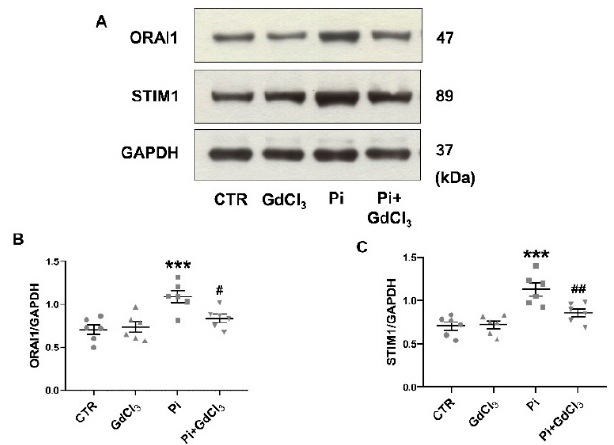
Figure 5. Reversal of ß-glycerophosphate-induced ORAI1 and STIM1 protein expression in megakaryocytes by GdCl 3 . ( A ) Original Western blots of ORAI1, STIM1 and GAPDH protein abundance in megakaryocytes without (CTR) and with prior 24-h exposure to 50 µ M GdCl 3 alone (GdCl 3 ), 2 mM ß-glycerophosphate alone (Pi) or 2 mM ß-glycerophosphate and 50 µ M GdCl 3 (Pi+GdCl 3 ). ( B , C ) Arithmetic means ± SEM ( n = 6) of ORAI1 ( B ) and STIM1 ( C ) protein abundance in megakaryocytes without (CTR) and with prior 24-h exposure to 50 µ M GdCl 3 alone (GdCl 3 ), 2 mM ß-glycerophosphate alone (Pi) or 2 mM ß-glycerophosphate and 50 µ M GdCl 3 (Pi+GdCl 3 ). *** ( p < 0.001) indicates statisti- cally significant difference compared to CTR; # ( p < 0.05), ## ( p < 0.01) indicate statistically significant differences compared to Pi alone (ANOVA). CTR,